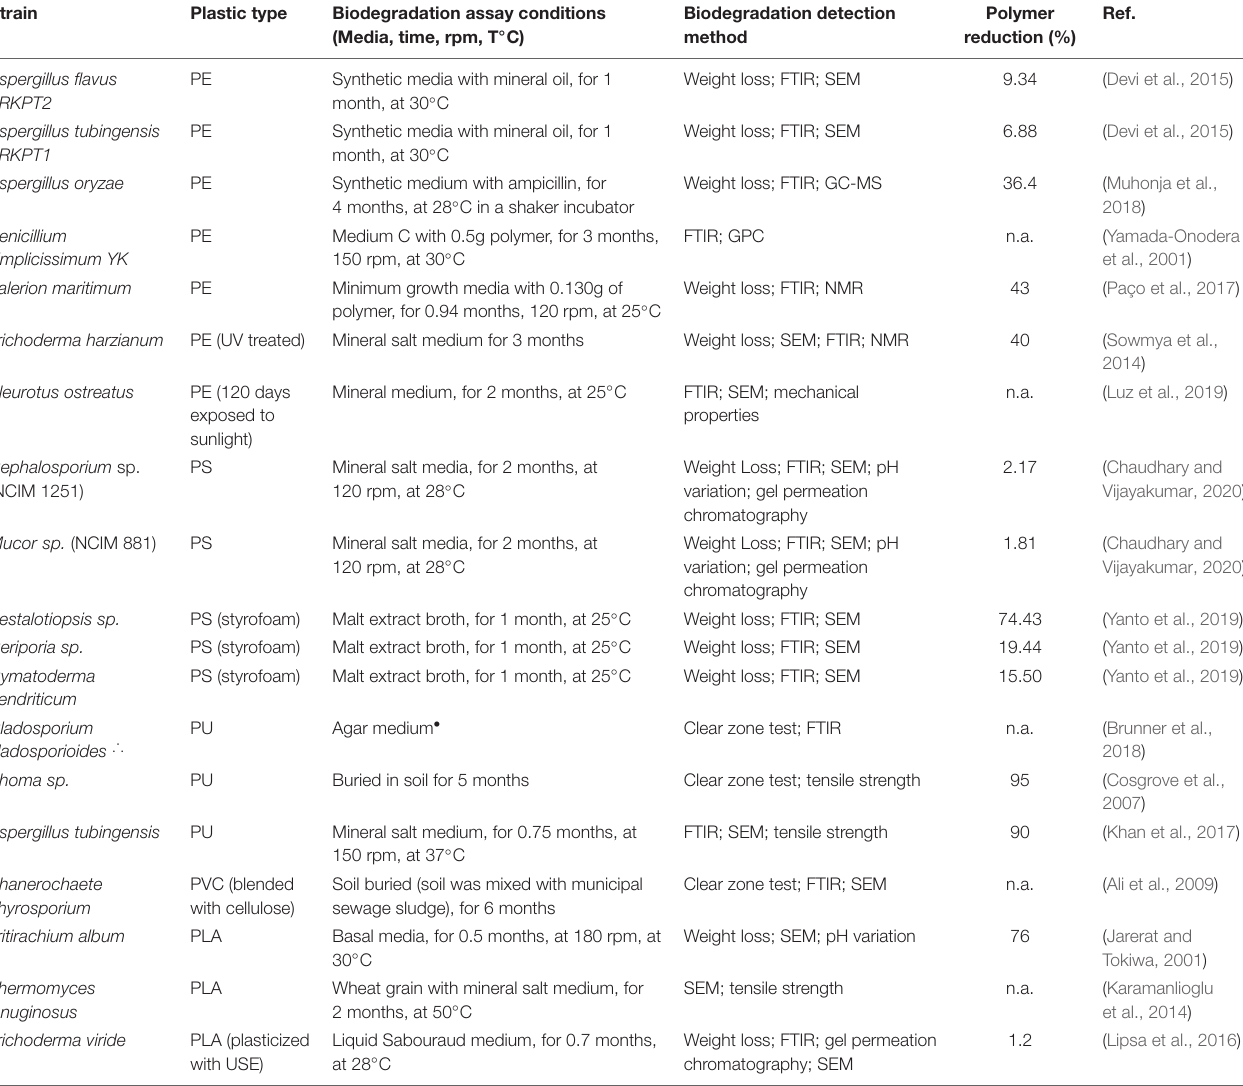
TABLE 4 | Plastics degraded by fungi, biodegradation assay conditions, and used detections methods. Strain